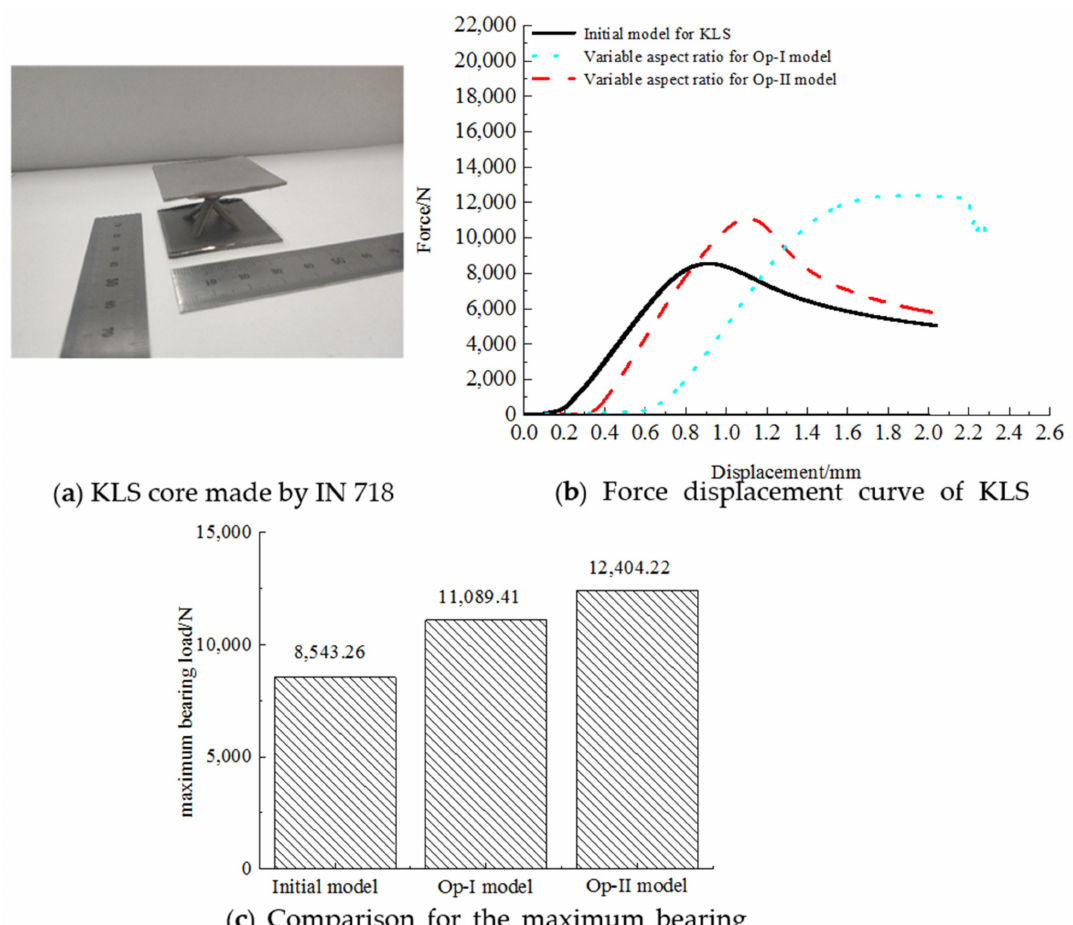
Figure 10. KLS core and the comparison data of KLS core.